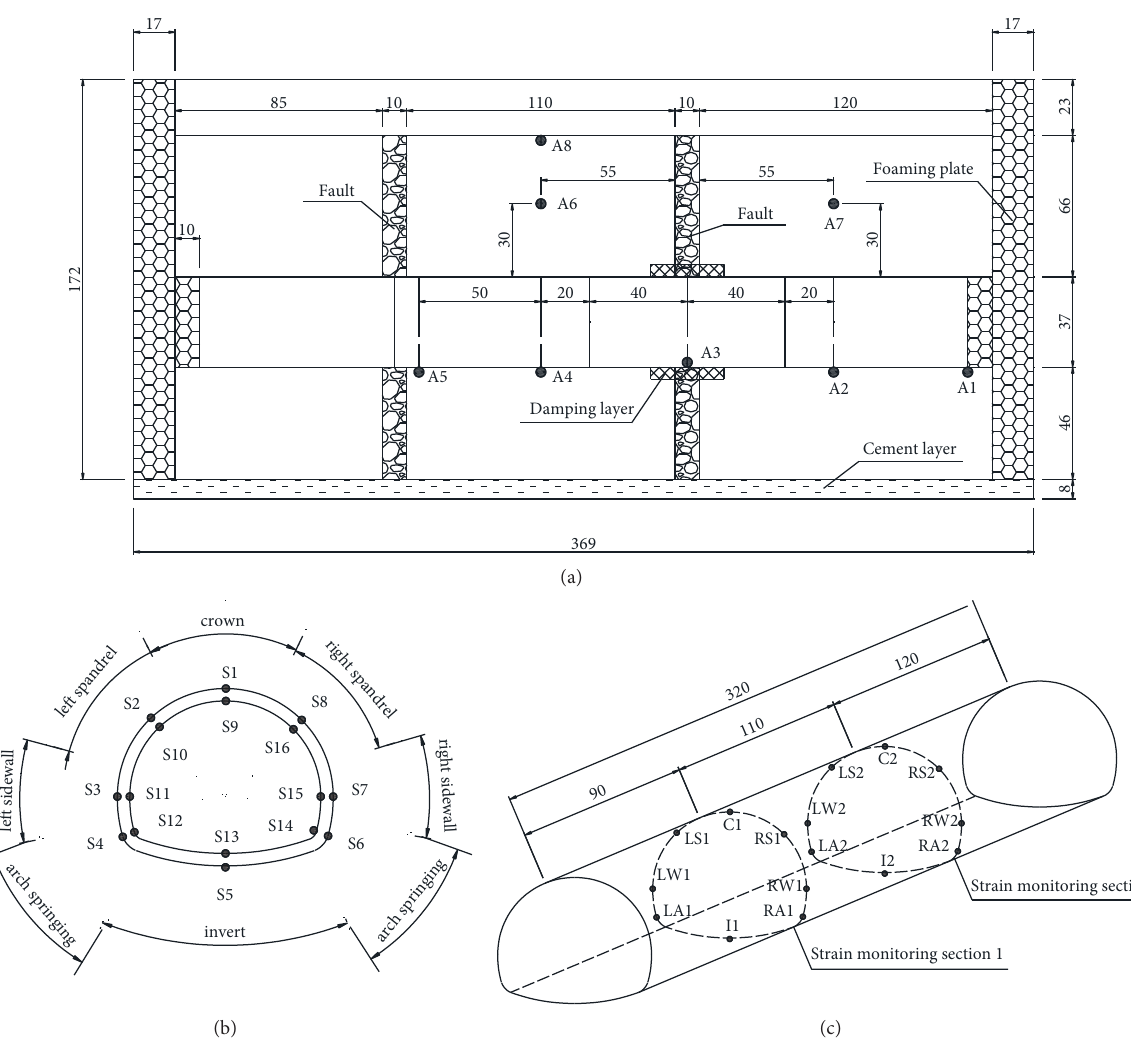
Figure 4: Layout of the shaking table test (all dimensions are in cm). (a) Longitudinal plane of the test and layout of accelerometers. (b) Cross section of layout for strain gauges. (c) Layout of strain monitoring sections.